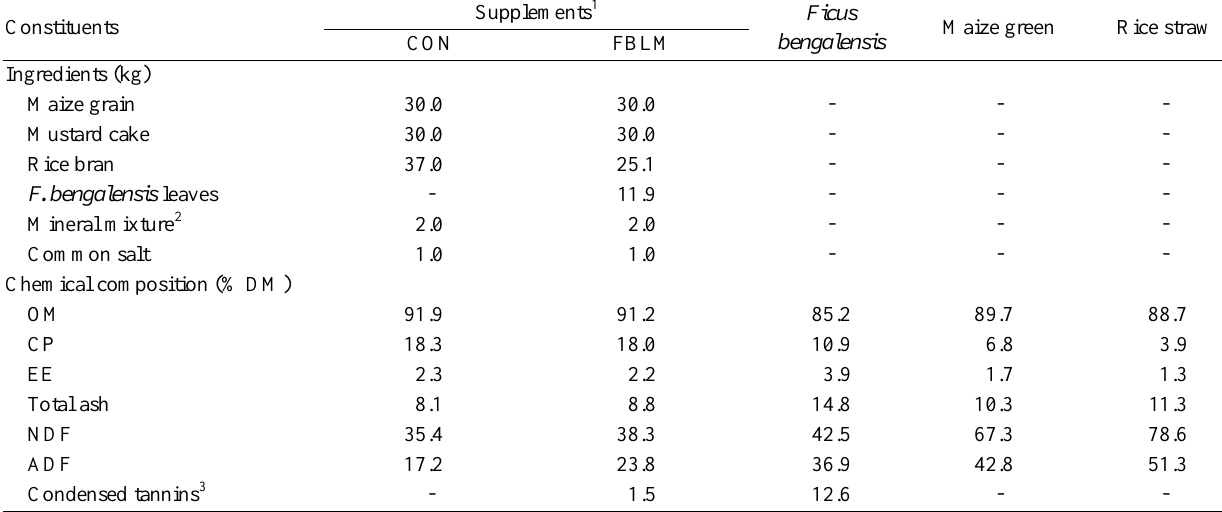
Table 1. Ingredients and chemical composition of supplements, Ficus bengalensis leaves and green maize